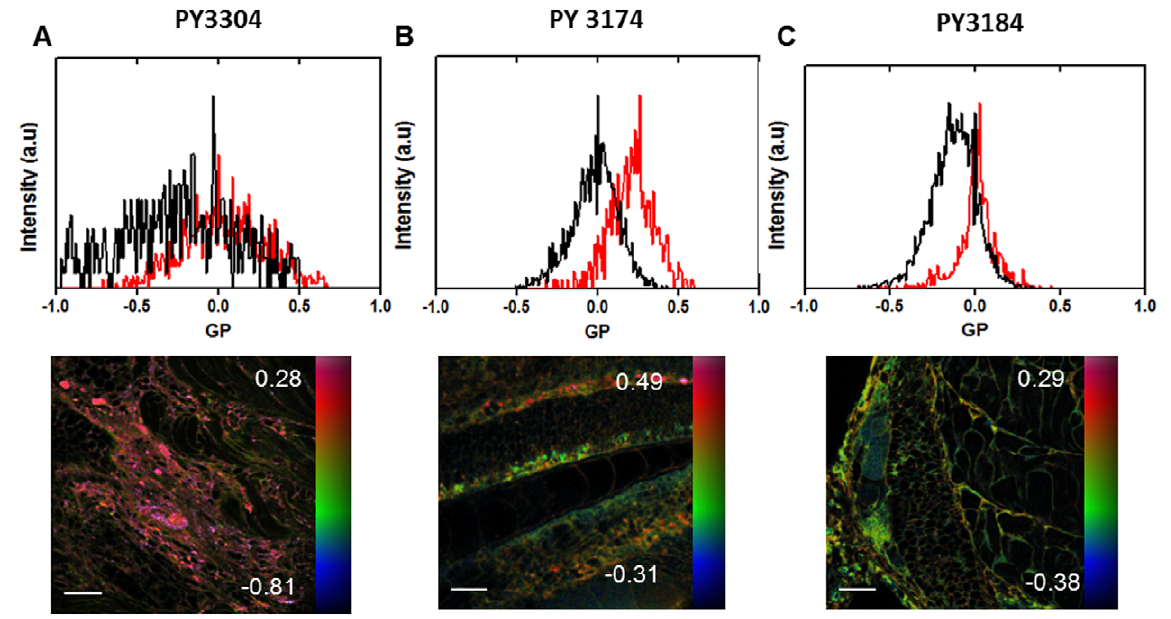
Figure 6. Analysis of live Zebrafish embryos. Top: Histograms of the GP values obtained from GP images of live Zebrafish embryos stained with PY3304 (A), PY3174 (B), PY3184 (C). Histograms obtained from ROIs for plasma membrane (red line) and intracellular membranes (black) were normalized to the total number of pixels. Bottom: GP images are in false color and run over the range indicated by the color bars to indicate a higher degree of membrane order (predominately colored red) in the plasma membrane compared to intracellular membranes (predominately colored green). Embryos were stained with PY3304 (left), PY3174 (middle), PY3184 (right) excited by multi-photon excitation at 1040 nm for PY3304, 900 nm for PY 3174, 1000 nm for PY 3184. Scale bars =10 m m.